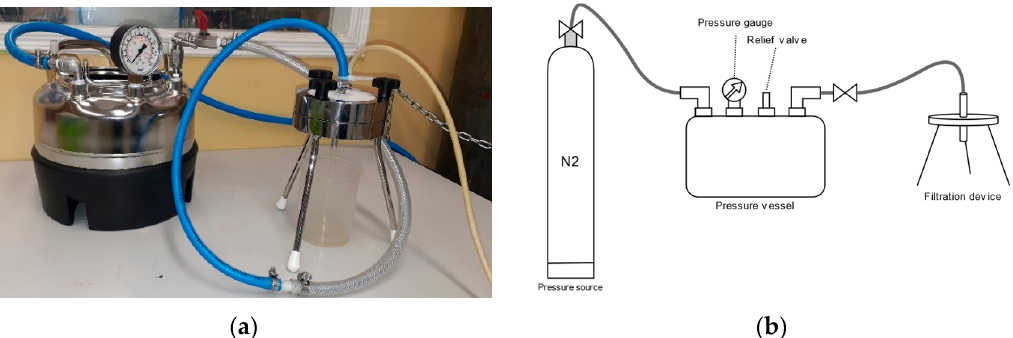
Figure 1. Sterlitech pressure filtration vessel: ( a ) photograph; ( b ) diagram.